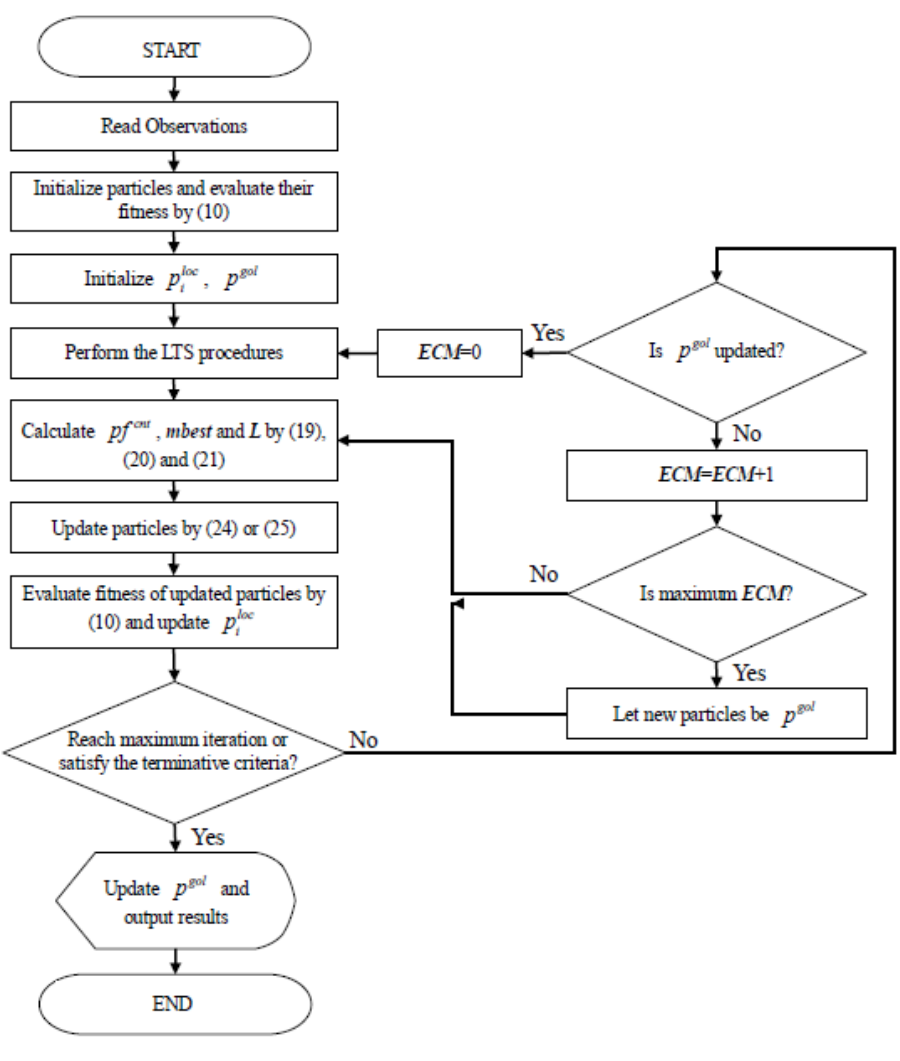
Figure 4. The flow chart of the proposed LTS-MQPSO